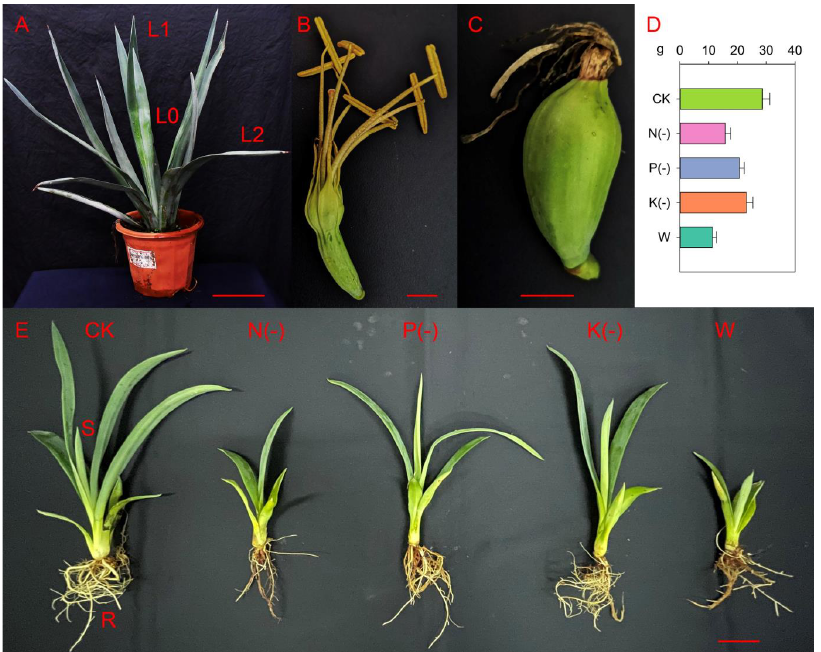
Figure 2. Photographs of agave plants ( A , bar = 10 cm), flower ( B , bar = 1 cm), fruit ( C , bar = 1 cm), nutrient deficiency-induced biomass ( D ) and morphological features ( E , bar = 5 cm) of agave seedlings. L0, L1 and L2 represent shoot, unexpanded leaf and expanded leaf in potted agave plants, respectively. CK, N(-), P(-), K(-) and W in D and E represent that the agave seedlings were cultured with full-, nitrogen free-, phosphorus free-, potassium free-Hoagland nutrient solutions and water, respectively. Shoot (S) and root (R) of agave seedlings are shown in ( E ).